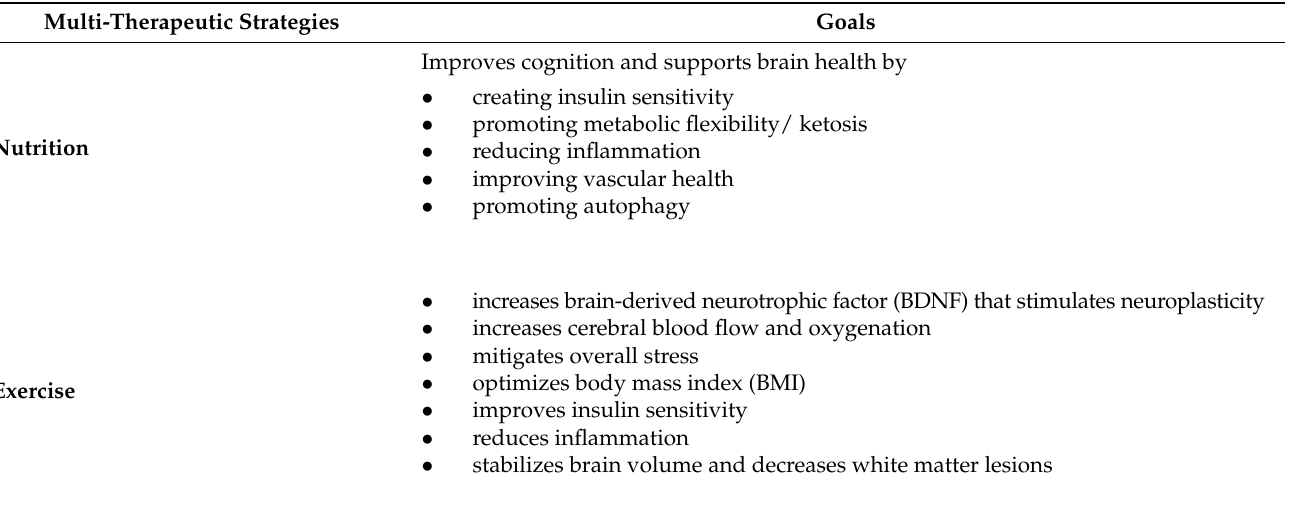
Table 2. Reversing AD-associated cognitive health requires addressing potential contributors to cognitive decline with a personalized, multi-therapeutic approach. Each of the strategies mentioned in the table has the ability to improve cognition and brain health, and when practiced together, they create a powerful synergy with sustained